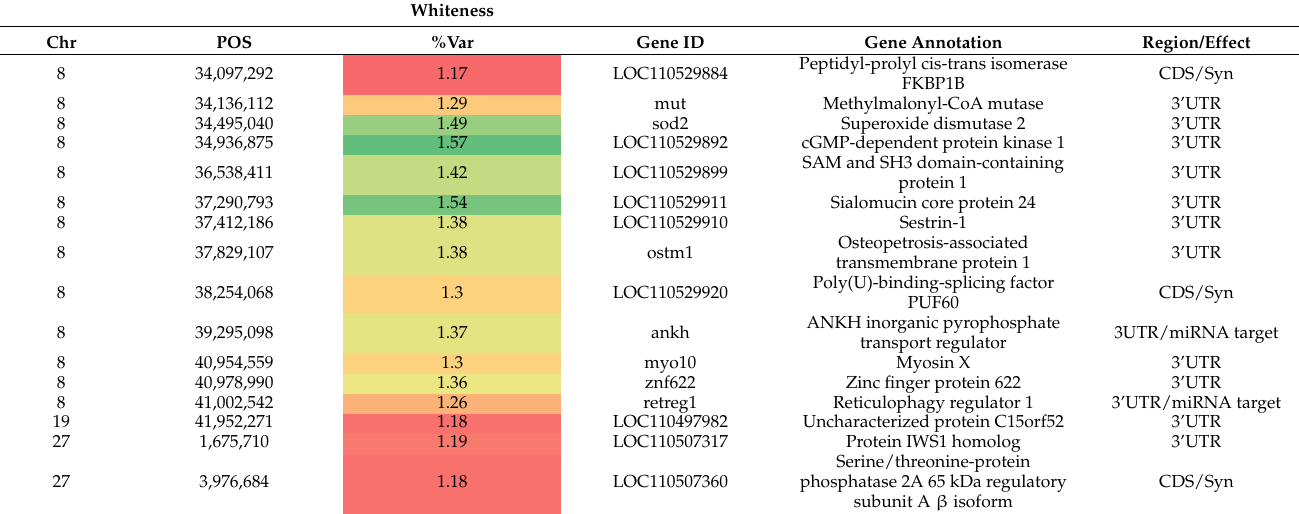
Table 3. Selected SNP markers within 50 SNPs’ genomic sliding windows, explaining at least 1% of the additive genetic variance for the fillet whiteness